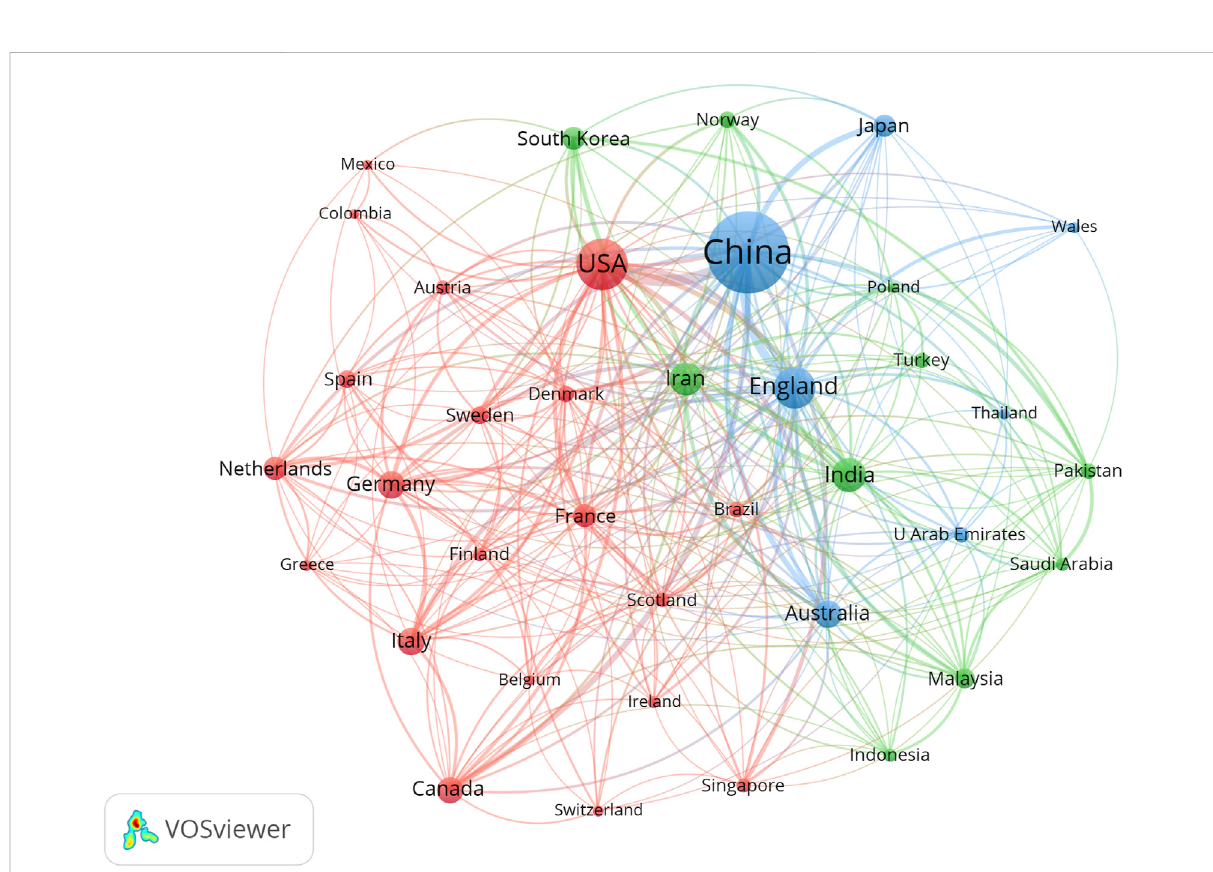
FIGURE 4 The cooperation mapping between main countries based on the co-authorship of papers in the area of